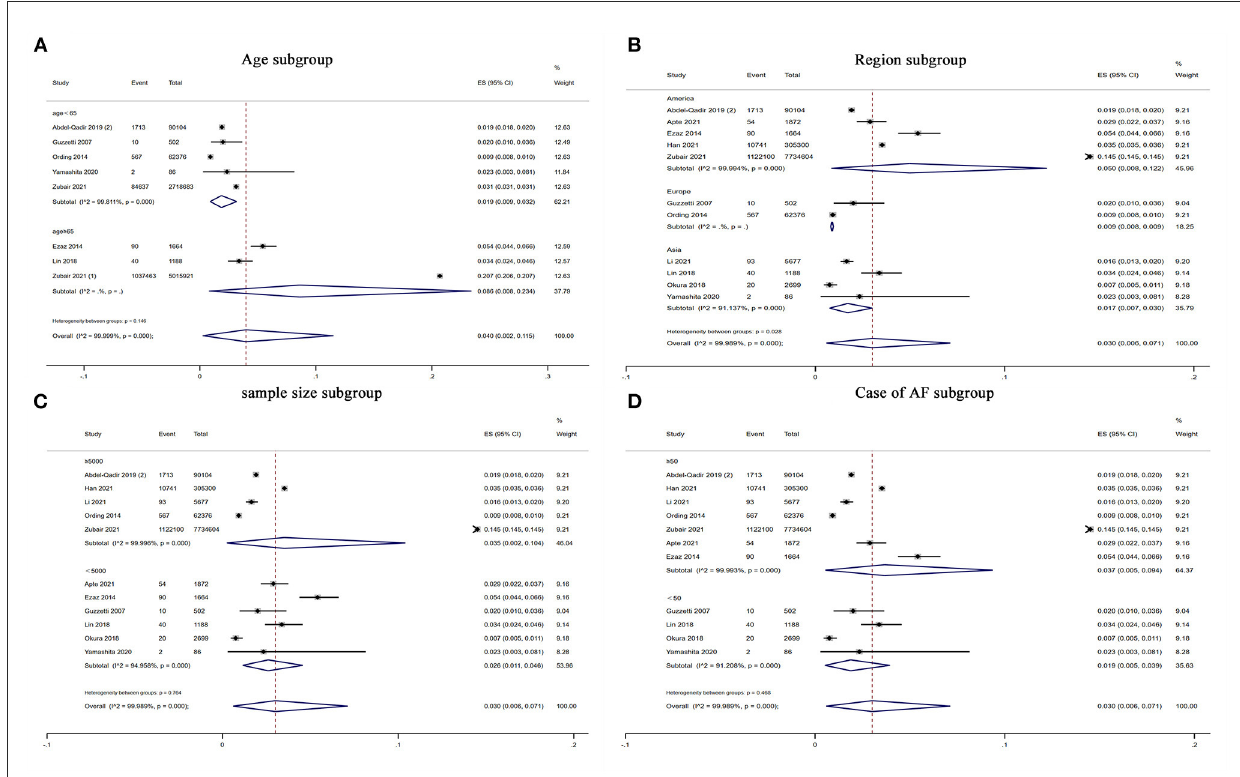
FIGURE3 Forest plot of subgroup analysis for prevalence of AF in patients with BC. There were (A) age subgroup, (B) region subgroup, (C) sample size subgroup and (D) case of AF subgroup. Inside the forest plot, the rhombus indicates the pooled estimate. Black squares and black vertical lines indicate 95%CIs around the effect size estimate. AF, atrial fibrillation; BC, breast